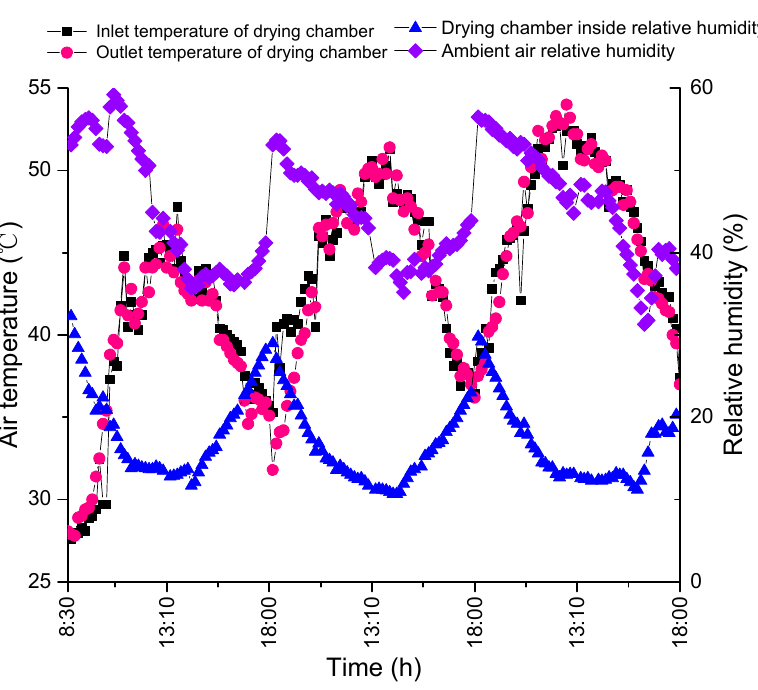
Figure 12. The variation of different parts’ temperature and relative humidity.